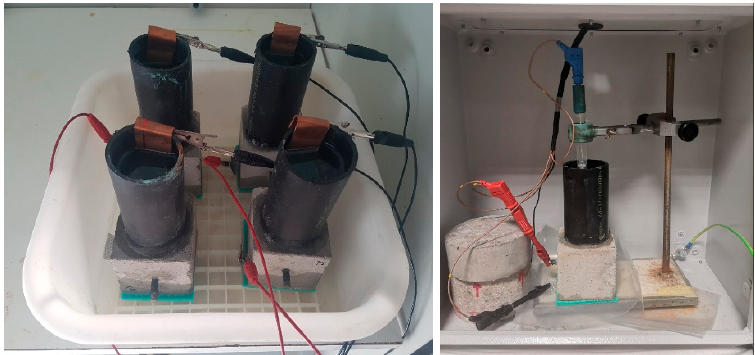
Figure 4. Accelerated corrosion test setup.